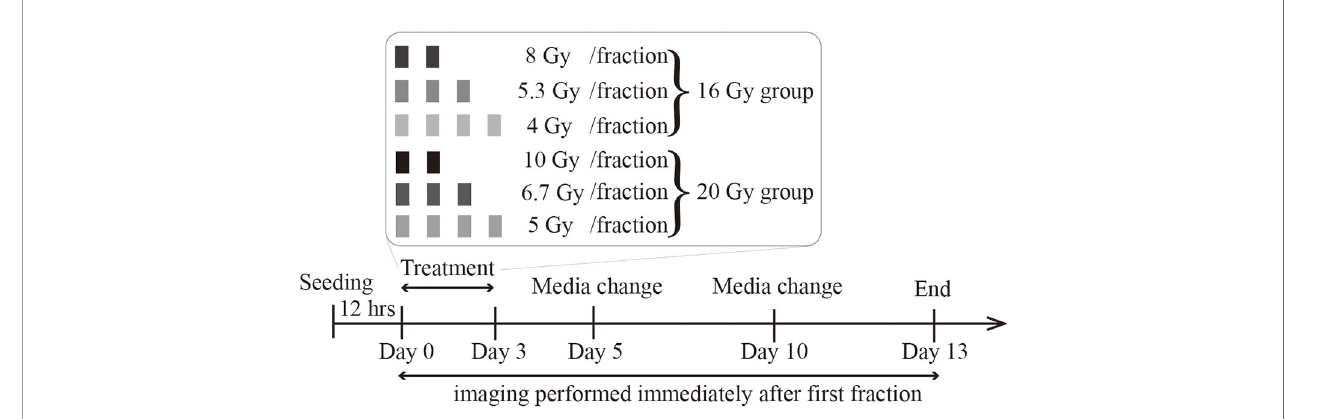
FIGURE 1 | Radiation treatment schedule. Cells are seeded, incubated overnight, and then treated with either a total dose of 16 Gy or 20 Gy. In the 16 Gy total dose group, cells are irradiated with 2 fractions of 8 Gy, 3 fractions of 5.3 Gy, or 4 fractions of 4 Gy. In the 20 Gy total dose group, cells are irradiated with 2 fractions of 10 Gy, 3 fractions of 6.7 Gy, or 4 fractions of 5 Gy. All irradiations are 24 hours apart. The culture media is refreshed every 5 days, and imaging lasts up to two weeks after the initial